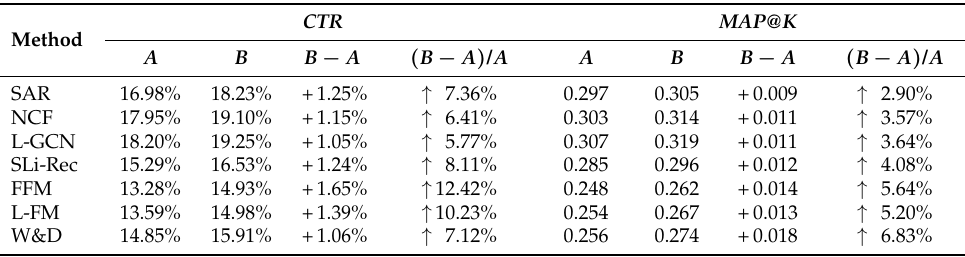
Table 4. The results of A/B experiments for categorial information on the MovieLens dataset ( A : w/o genre; B :